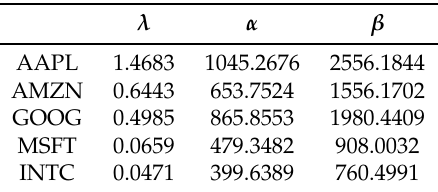
Table 2. Each parameter was estimated using a particle swarm optimization method in an attempt to globally optimize the negative log-likelihood function. The values for λ , α and β for each data set are as provided.